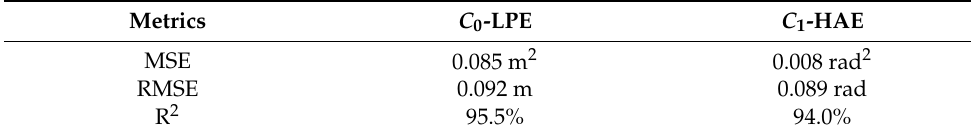
Table 4. Performance evaluation of MLP for C 0 -LPE and C 1 -HAE estimation.